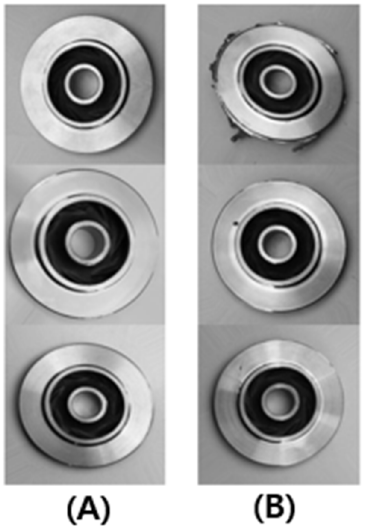
Figure 5. Casting image dataset: ( A ) normal casting image; ( B ) abnormal casting